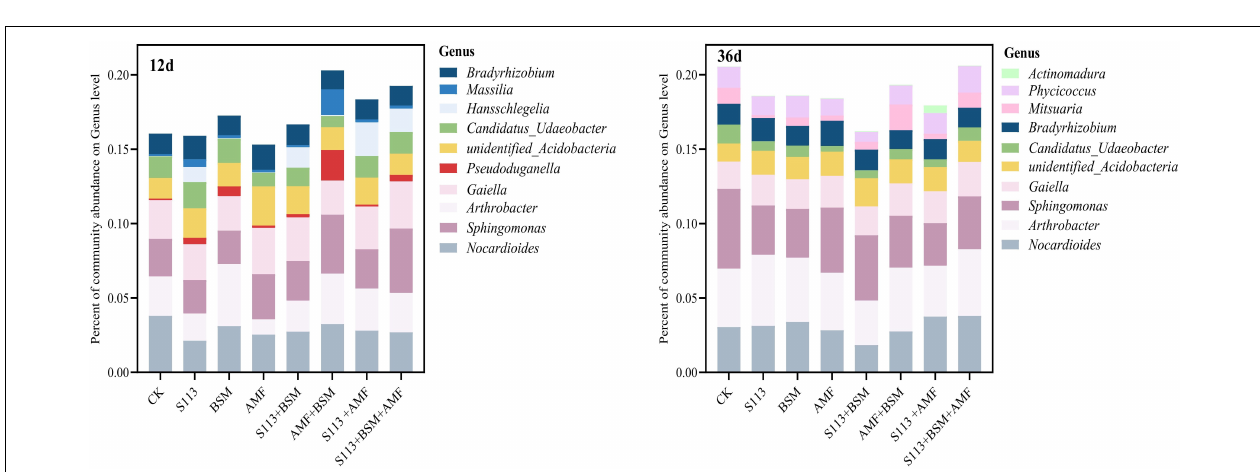
FIGURE 7 | Shannon diversity index for microbial communities of different treatments on the 12th day and 36th day. Note: CK: the seedlings without Bensulfuron-methyl (BSM) and S113 or Arbuscular mycorrhizal fungi (AMF); S113: seedlings were inoculated with S113 by root irrigation; BSM: soils were treated with bensulfuron-methyl, 3.0 mg/kg; AMF: seedlings were inoculated with AMF spore suspension (200 µ L); S113 + BSM: seedlings were treated with BSM and inoculated with S113; AMF + BSM: seedlings were treated with BSM and inoculated with AMF spore suspension; S113 + AMF: seedlings were inoculated with S113 and AMF spore suspension; S113 + BSM + AMF: seedlings were inoculated with S113 and AMF spore suspension, and soils were treated with BSM. Values with different letters are significantly different at the P < 0.05 according to Duncan’s test.